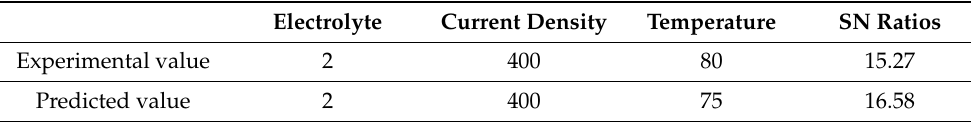
Figure 2. Main effects plot of the mean signal-to-noise ratios with surface roughness. Table 7. Optimization conditions with roughness signal-to-noise